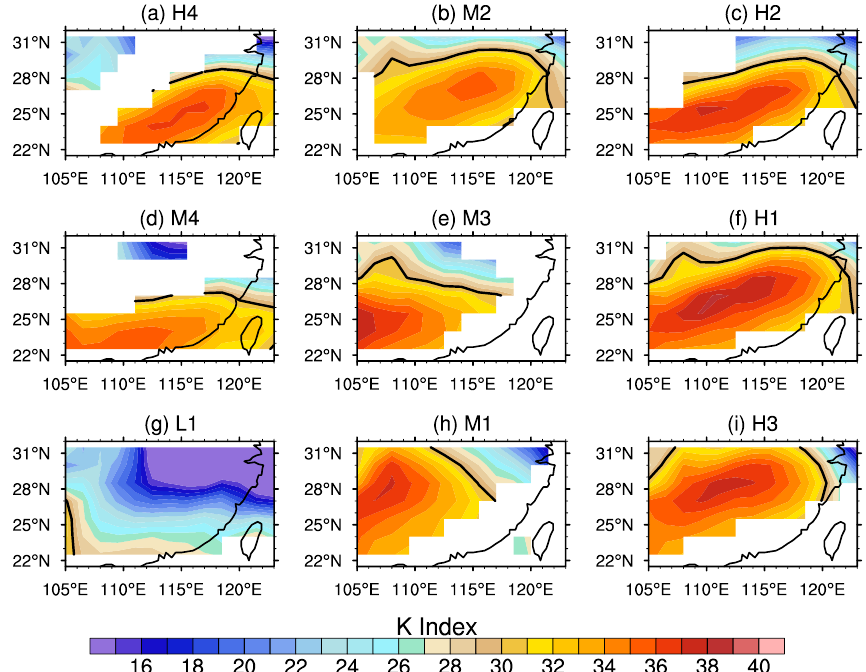
Figure 11. ( a – i ) Composite means of K index for the nine regimes during AMJ 1979–2015. The black line in each panel is the contour of 30. Only composite means that pass the 95% confidence level based on two-sided Student’s t test against the complementary set of samples are